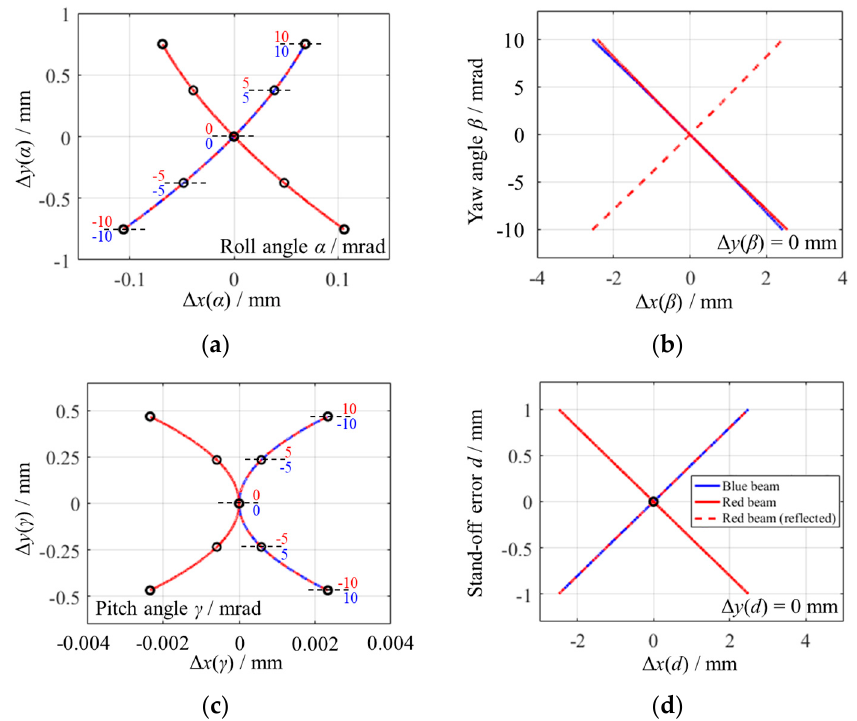
Figure 7. The results of beam tracing with the variation of misalignment angles and the stand-off error shown by the curves of the beam centers. ( a ) Roll angle α . ( b ) Yaw angle β . ( c ) Pitch angle γ . ( d ) Stand-off error d . These curves share the legend shown in figure ( d